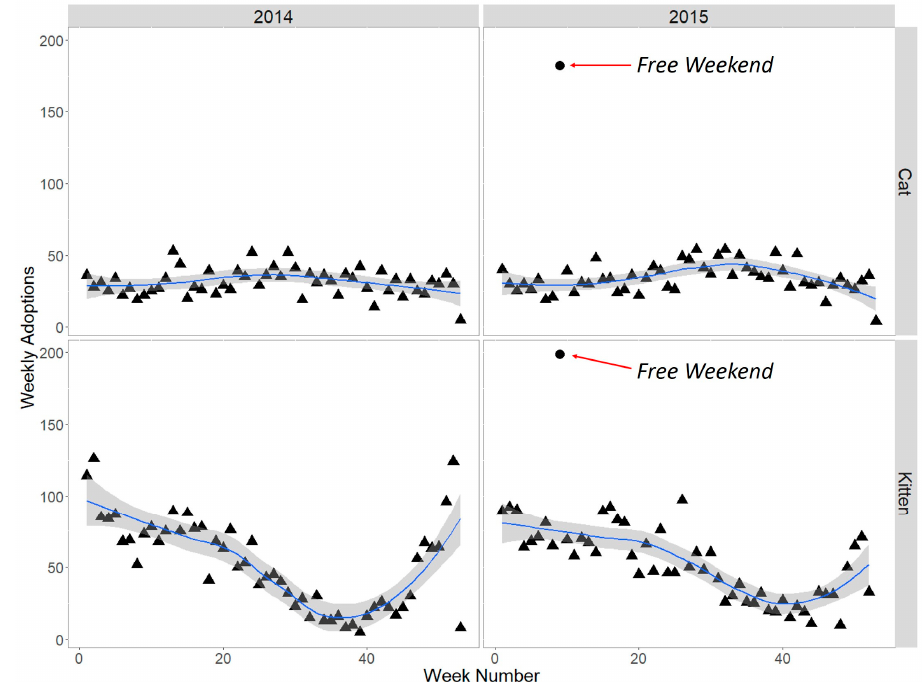
Figure 1. Weekly cat and kitten adoptions 2014–2015 at the Cat Haven, WA, with a loess smoother and 95% confidence envelope. The free weekend dot indicates the number of adult and mature cats or kittens adopted during the entire week that included the adoption-drive. Free weekends increased cat adoptions by 533% and kitten adoptions by 381% relative to 2015 weekly averages.